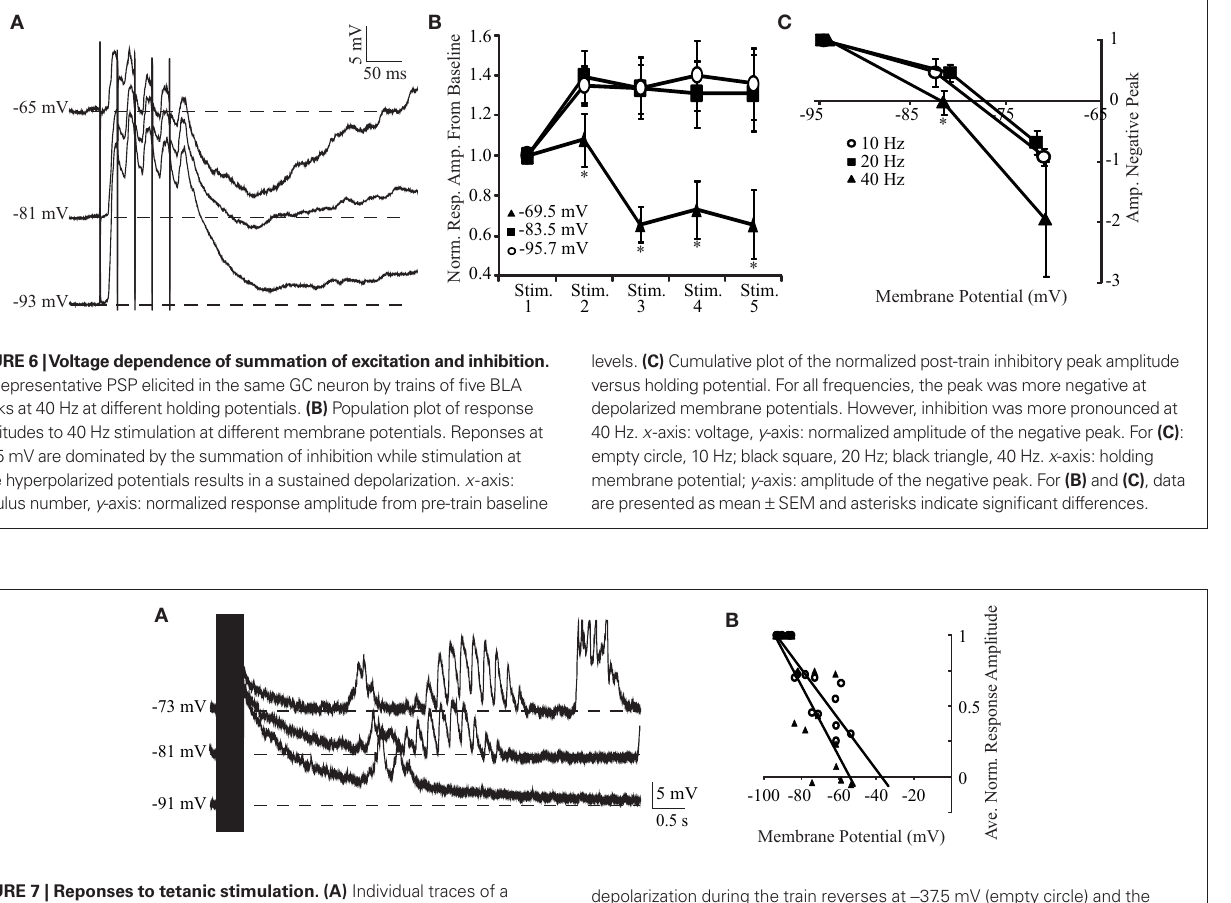
depolarization during the train reverses at − 37.5 mV (empty circle) and the post-train inhibitory peak reverses at −54.2 mV (black triangle). Single points are synaptic responses at different membrane potentials for five neurons. Lines represent the linear regression of the values. x -axis: voltage; y -axis: normalized amplitude of